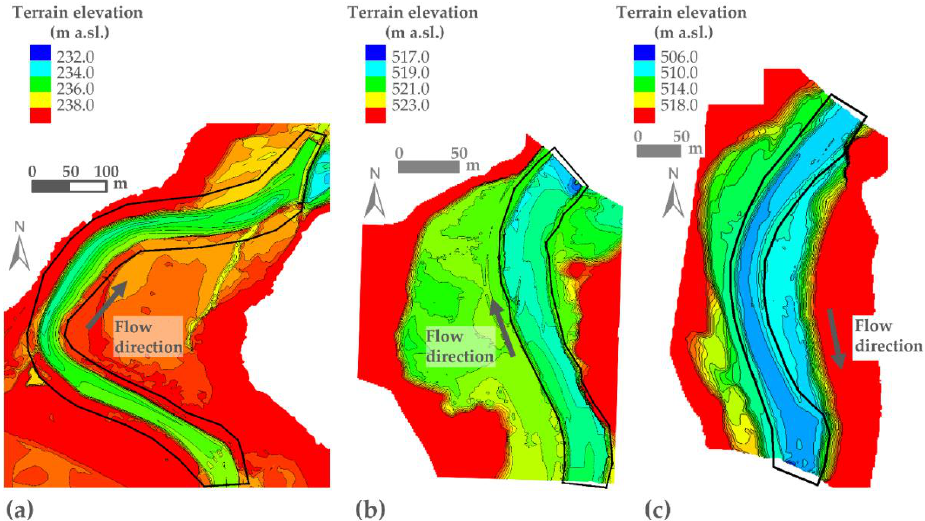
Figure 2. Terrain elevation models of the three case studies: ( a ) Erlauf River (C.1), ( b ) Alm River (C.2), c ) Schwarza River (C.3). Black line: bounds of the evaluation and ( c ) Schwarza River (C.3). Black line: bounds of the evaluation region. and (